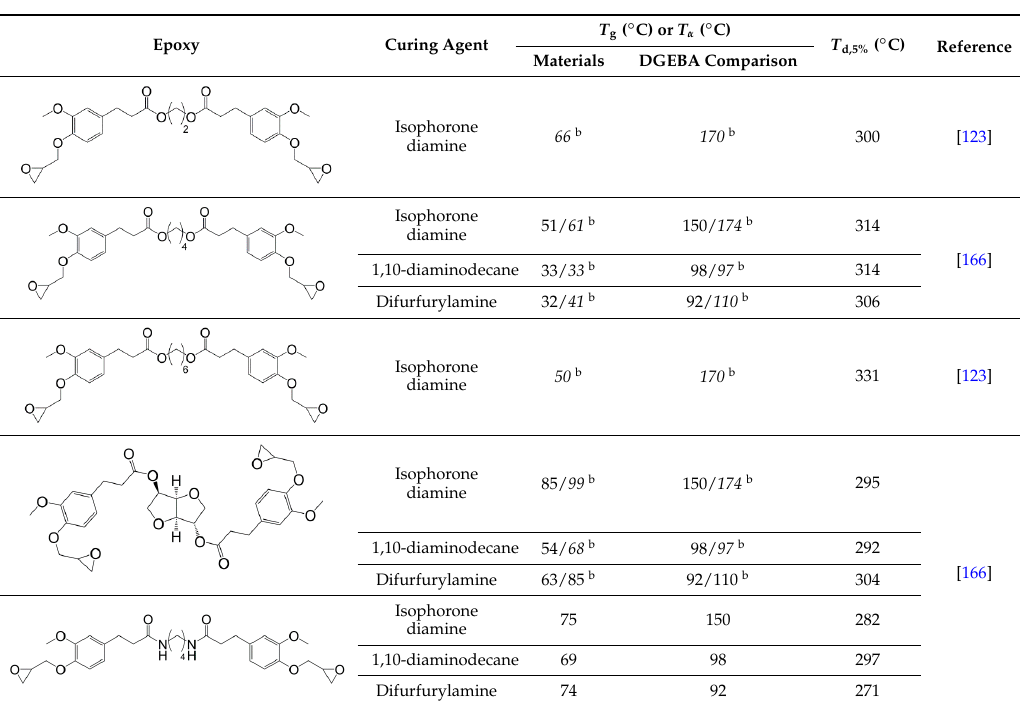
Table 4. Di-epoxy monomers with two aromatic rings separated by more than one atom exhibiting ester or amide bonds, and thermal properties of the cured materials.